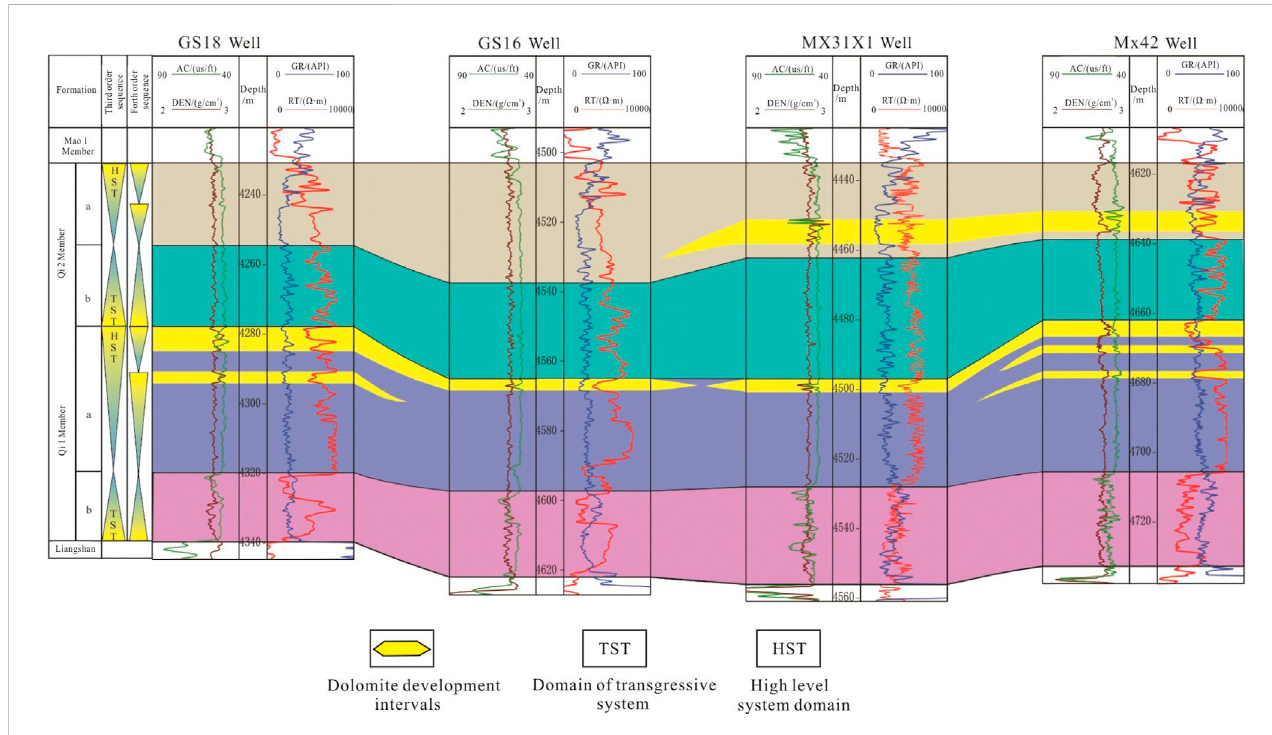
FIGURE 10 Interwell correlation pro fi le of dolomite reservoirs of Permian Qixia Formation in central Sichuan Basin.